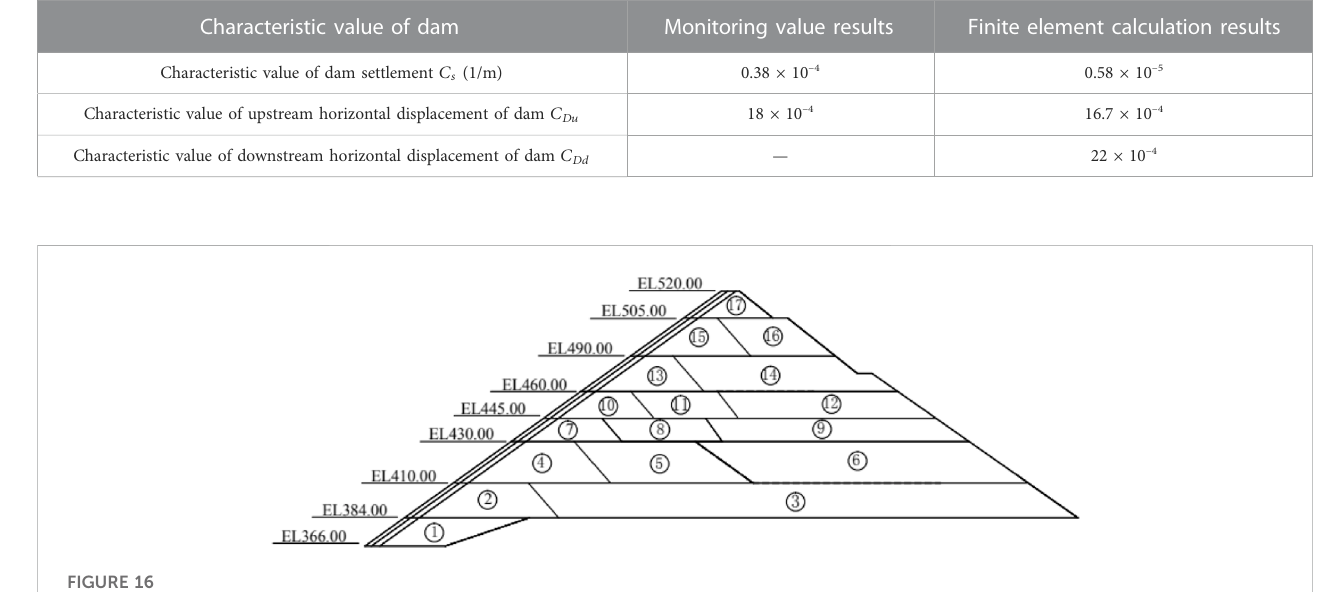
FIGURE 16 Plan Ⅱ of optimize the fi lling sequence.